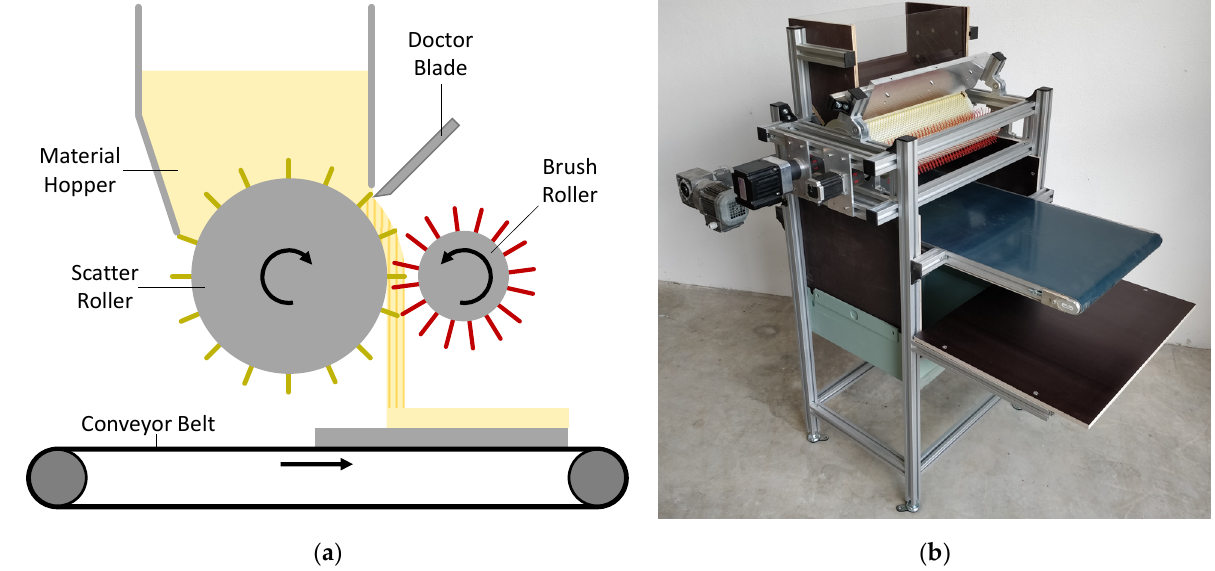
Figure 3. ( a ) Schematic of the scattering device; ( b ) image of the scattering device.